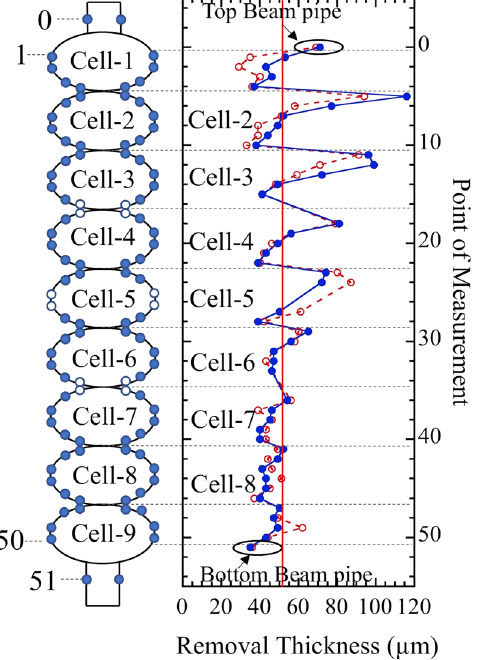
FIG. 11. Removal thickness along the cavity length in the VEP performed with parameters similar to those optimized for the single-cell cavity. The solid points in the schematic on the left show the positions where the thicknesses were measured. The vertical solid line shows the average removal